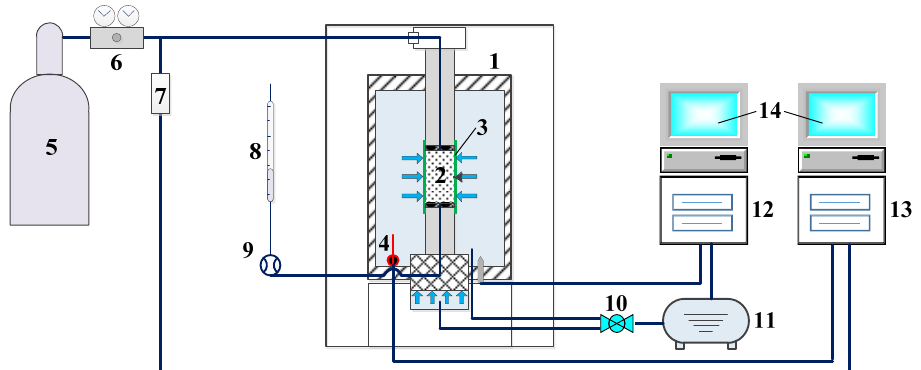
Figure 2. Low-permeability rock test system. 1—triaxial chamber; 2—rock sample; 3—rubber membrane; 4—the heater; 5—nitrogen; 6—regulator valve; 7—gas pressure sensor; 8—bubble flow me-